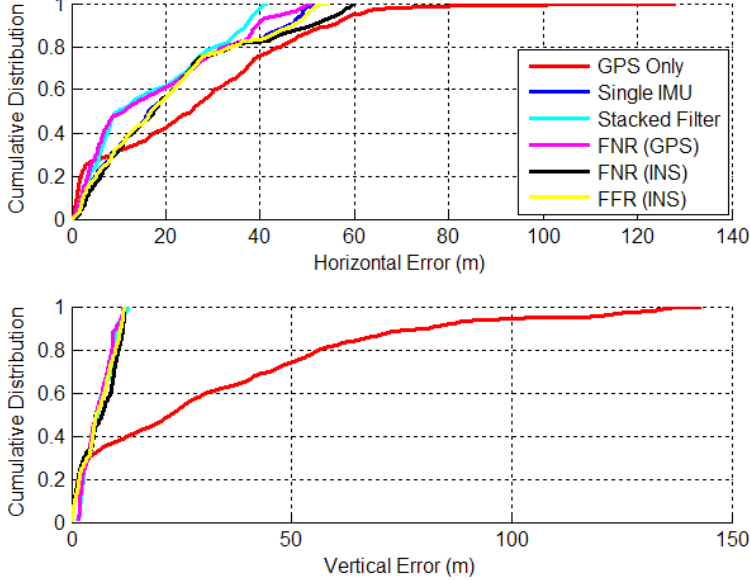
Figure 16. CD of Horizontal and Vertical Errors for Stacked and Federated Filters (Olympic Oval Data